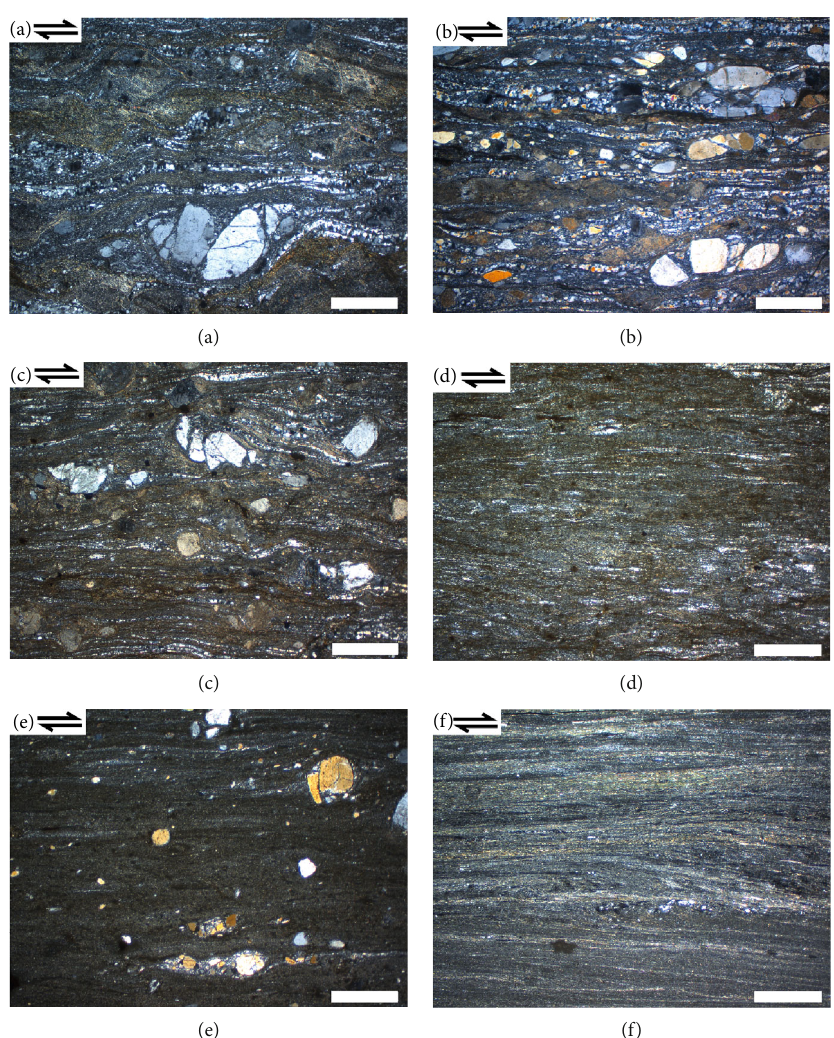
Figure 6: Photomicrographs of high-strain rocks from the KMZ. (a – c) are representative mylonites with feldspar porphyroclasts containing tensile and shear fractures, quartz ribbons, and a fi ne-grained matrix. (d – f) are representative ultramylonites, dominated by fi ne-grained mixtures of all constituent phases of the rock, with a few relict feldspar porphyroclasts. (a) Sample 31, Tsirub Gneiss from area C. (b) Sample 25, biotite gneiss from area D. (c) Sample 34, leucogranite from area C. (d) Sample 32, Tsirub Gneiss from area C. (e) Sample 10, biotite gneiss from area A. (f) Sample 42, leucogranite from area B. White bars = 1 mm